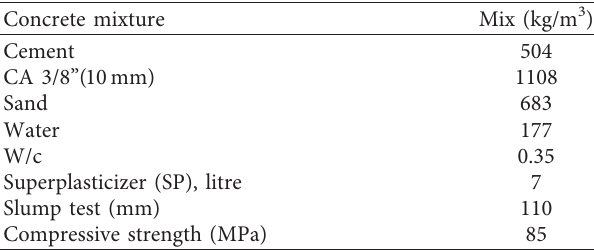
Table 2: The concrete proportions of normal